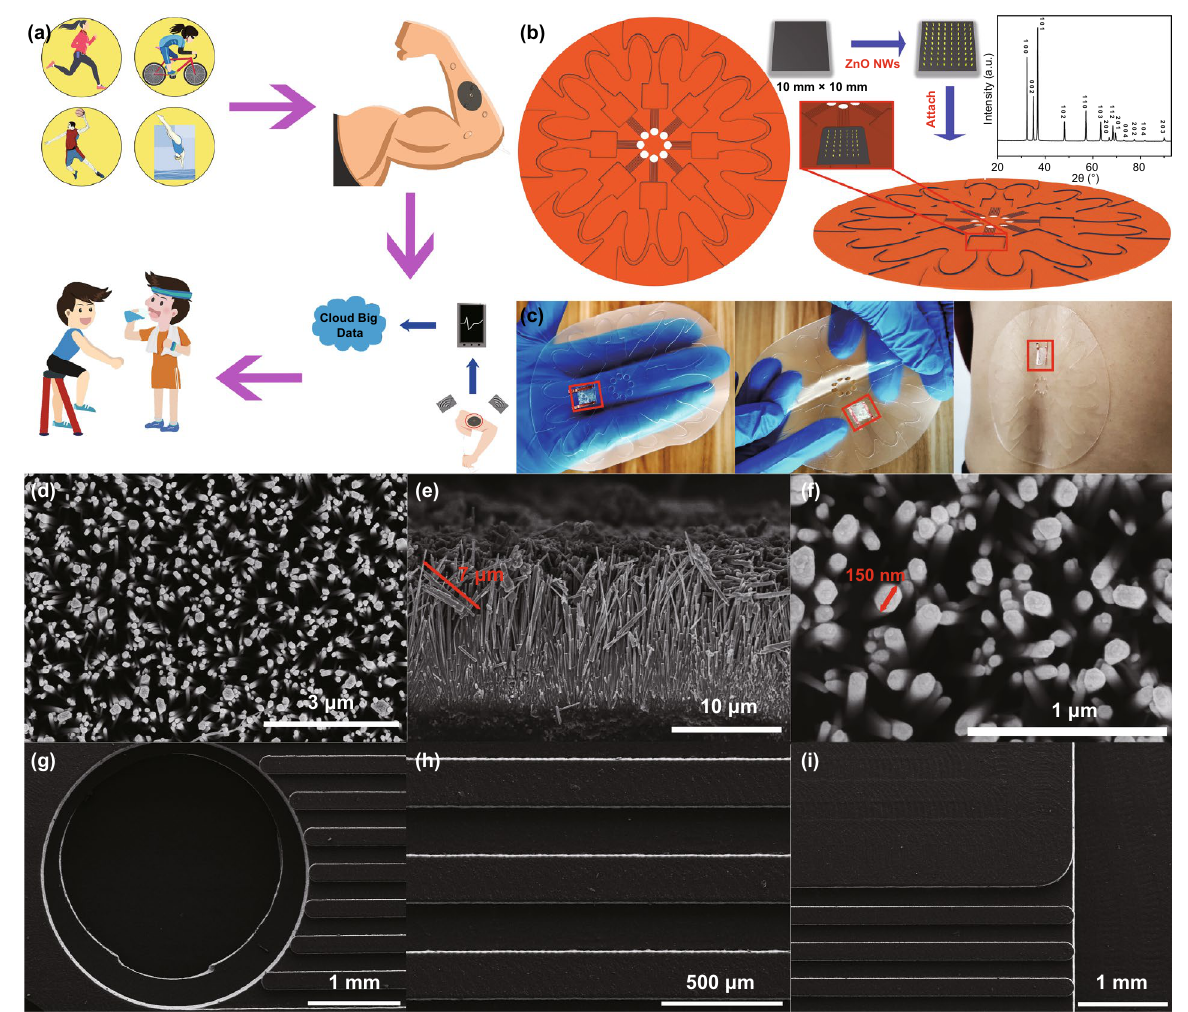
Fig. 1 a Potential application of the wearable battery-free perspiration analyzing sites. b Fabrication process, structure display, and XRD dif- fraction pattern of the device. c Optical image of the device. d – f SEM images of ZnO NWs grown on PDMS film. g – i SEM images of the flex- ible skin-like PDMS